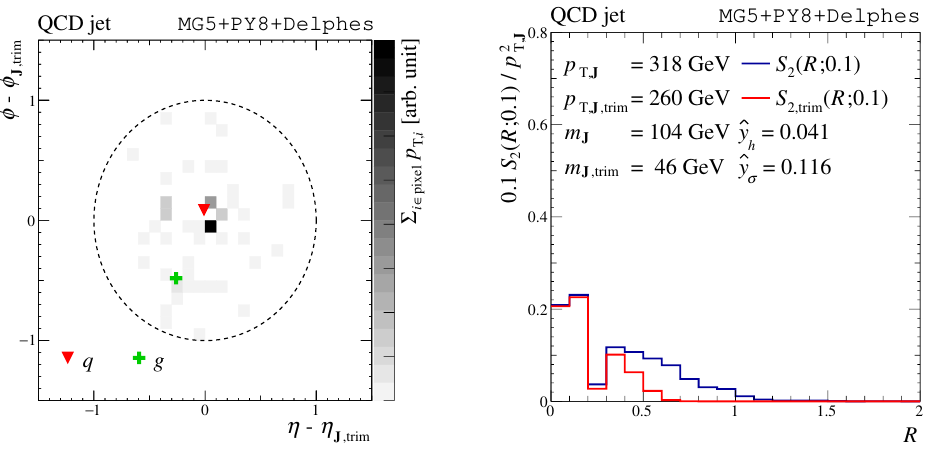
Figure 1 . A jet image (left) and the corresponding S 2 (blue) and S 2 ; trim (red) spectra (right) of the leading jet of a pp Zj event. In the jet image, a red triangle is a position of a parton level ! quark in the jet, and a green \+" shows a leading gluon emitted from the